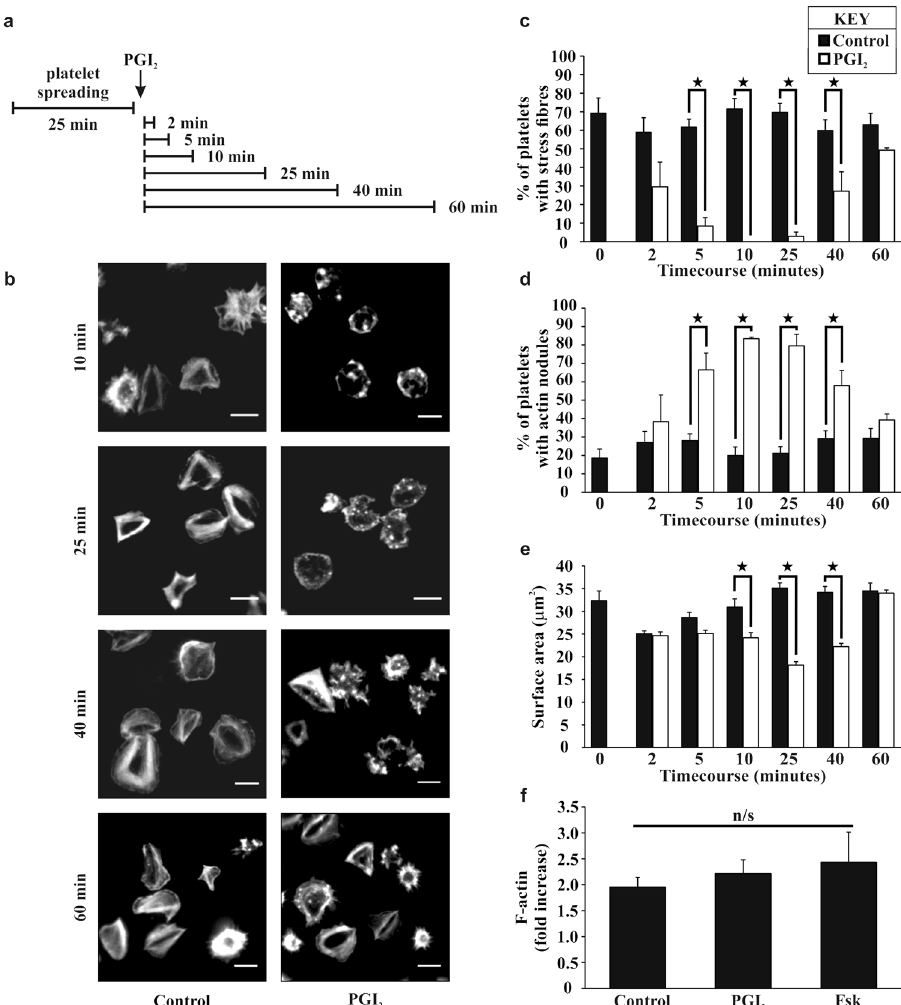
Figure 2. Post treatment of PGI 2 induces stress fibre reversal and actin nodule formation in platelets spread on fibrinogen in a time dependent manner. Platelets (2 × 10 7 /ml) were spread on 100 μ g/ml fibrinogen for 25 minutes, washed with PBS, and then 10 nM of PGI 2 was added, for a further 2–60 minutes as per the representative experimental design in part ( a ) The platelets were then fixed and stained with FITC-phalloidin before being imaged via fluorescent microscopy. ( b ) Representative images of each condition of the experiment. ( c ) The number of spread platelets containing stress fibres was identified in control and PGI 2 treated samples. ( d ) The number of spread platelets containing actin nodules was identified in control and PGI 2 treated samples. ( e ) The average surface area of the spread platelets was analysed for each timepoint in control and PGI 2 treated samples. Analysis was performed using Image J. The experiments are an average of n = 5. p < 0.05. Scale-bar 5 μ m. ( f ) Platelets were spread as above for 25 minutes and then treated for 10 minutes with either 10 nM PGI 2 or 1 μ M forskolin. Assessment of the filamentous actin was performed using the F-actin assay. The experiments are an average of n =